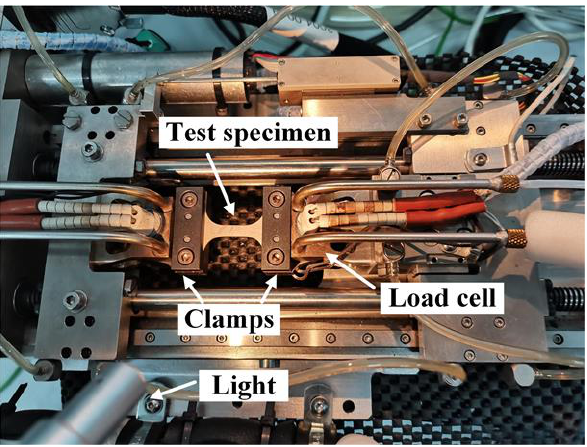
Figure 4. DIC system for tensile test.